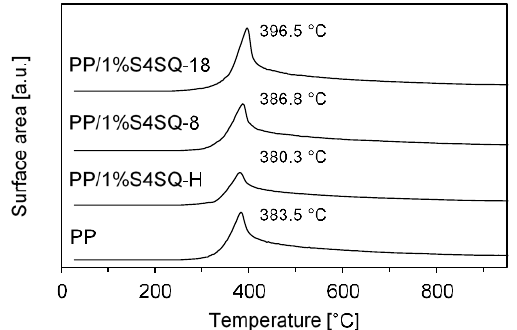
Figure 5. The evolution curves of the hydrocarbons (in the range of 2800–3000 cm − 1 ) evolved from neat PP and PP/S4SQ composites vs. temperature.